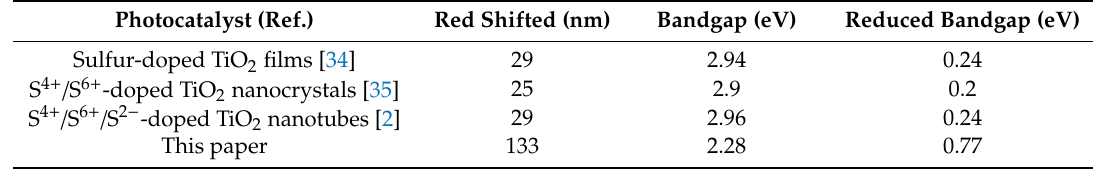
Table 4. The cut-off wavelength, intrinsic absorption intensity (IA), visible light absorption intensity (VA), bandgap of theoretical value (Bandgap T) and bandgap of TiO 2 -doped with different ratios of anionic S 2 − .